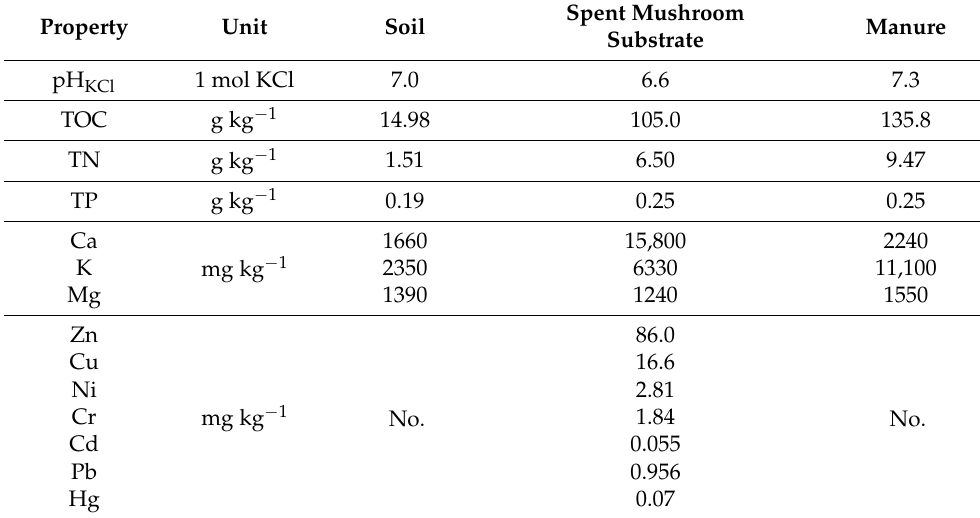
Table 1. Properties of soil and wastes